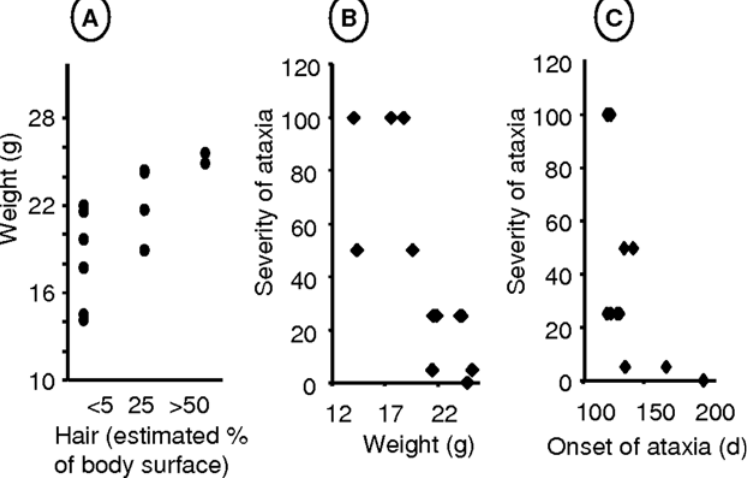
Figure 3. Correlations among the severities of the major abnormalities in Harlequin mice. A: Baldness (% body surface area) plotted against body weight in Hq males (n=12). B, C: Ataxia (number of falls per min) plotted against body weight (B) or against the age at the first recorded sign of ataxia (C).